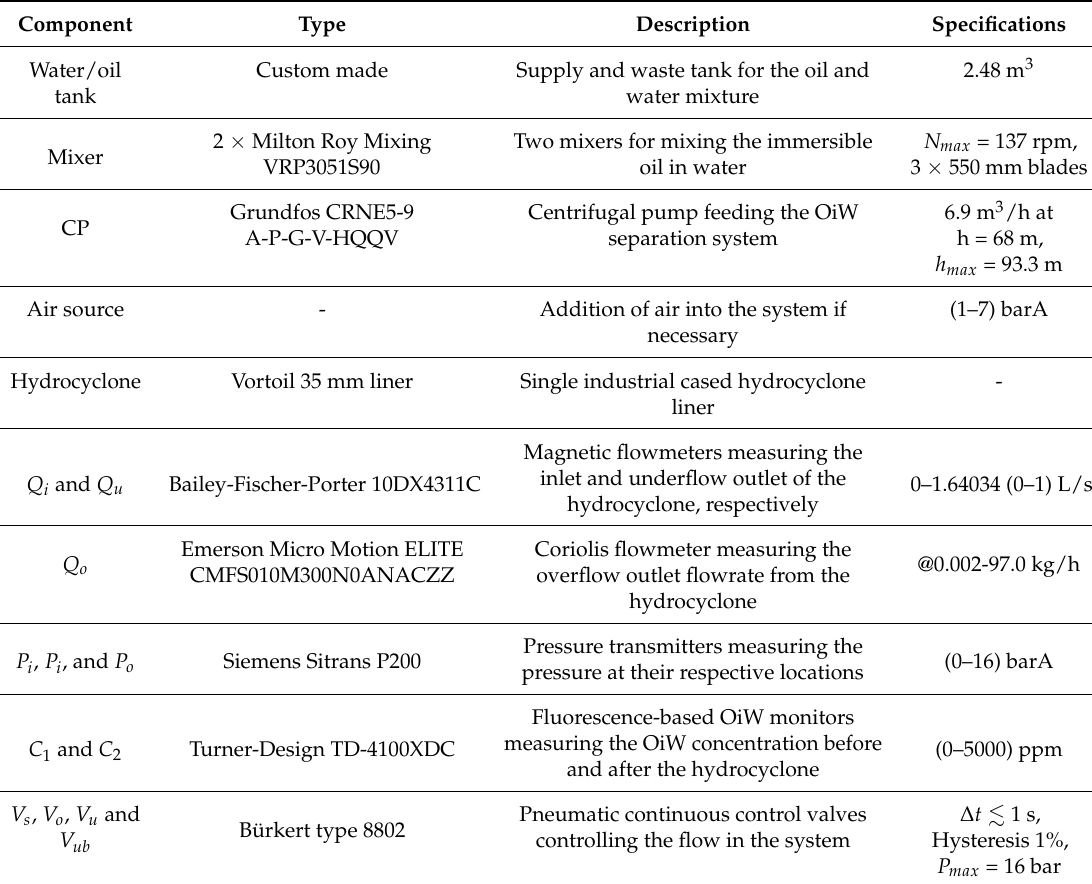
Table 2. Specifications of instruments used in the pilot-plant process. An illustration of the instruments’ position is seen in Figure 5a.